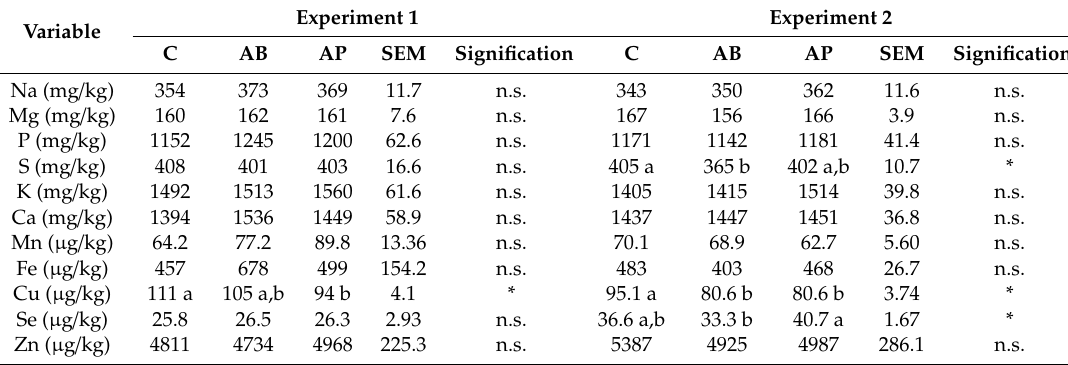
Table 4. E ff ect of the diet on milk mineral profile in Experiments 1 and